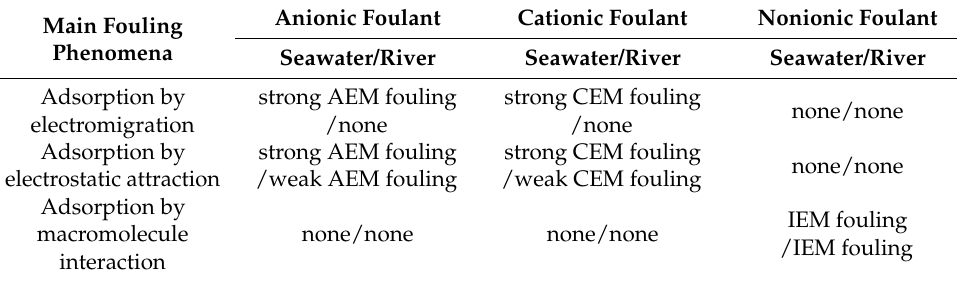
Table 3. Summary of the expected fouling results occurred in RED systems.